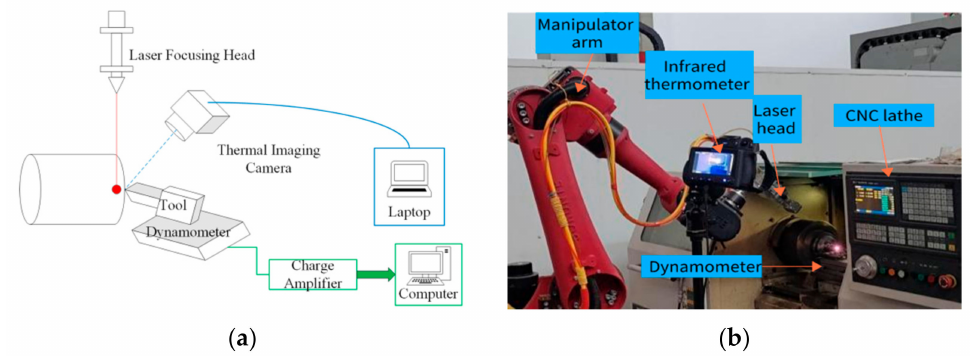
Figure 1. Laser-assisted turning system: ( a ) schematic of the system components; ( b ) physical view of the